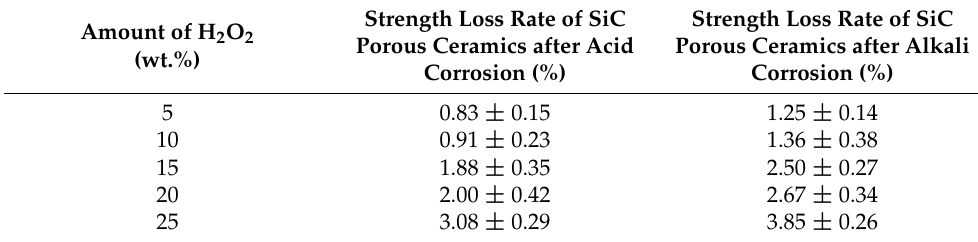
Table 1. Strength loss rate of SiC porous ceramics after acid/alkali corrosion.